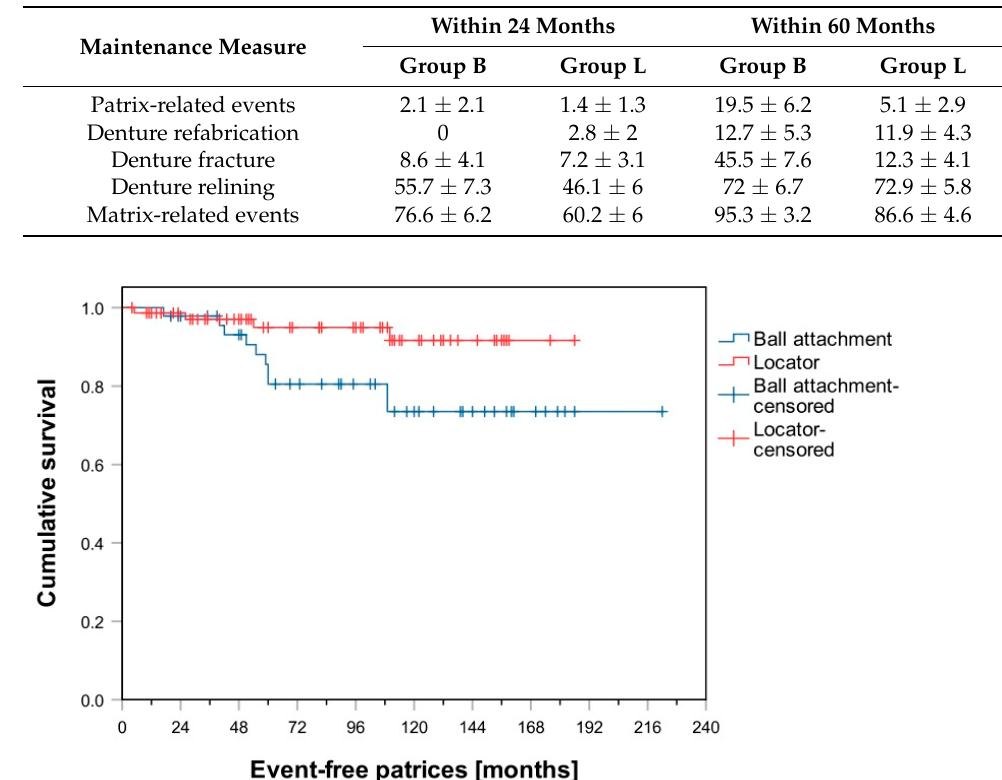
Figure 3. Kaplan–Meier survival curves for “denture fracture”: Ball versus Locator attachments. The OHIP-G14 questionnaire was filled out by 78 patients after the completion of prosthetic treatment (Group B: 27, Group L: 51). Analysis yielded a total OHIP score (mean ± SD) of 10.4 ± 4.45 points for Group L and 13.9 ± 5.16 points for Group B, signifying a significant difference between the two groups ( t -test, p = 0.002). 4. Discussion The aim of this study was to evaluate possible differences between Locator ® and ball attachments in implant-retained mandibular overdentures in terms of prosthetic mainte- nance. The results revealed that the two attachment systems did differ with regard to prosthetic maintenance and the effect on OHRQoL. The null hypothesis could therefore be rejected. Analysis of the evaluated maintenance measures demonstrated an increasing num- ber of necessary maintenance associated with increasing observation time. In general, a higher need for maintenance occurred in dentures retained by ball attachments, which negatively affects their survival time compared to prostheses in Group L.